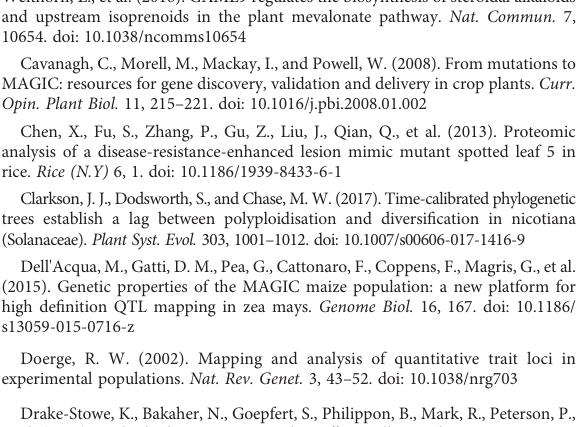
SUPPLEMENTARY FIGURE 1 Kinship matrix among the 560 MAGIC lines of tobacco MAGIC population using SNP markers. SUPPLEMENTARY FIGURE 2 Q-Q plots of nicotine content across different